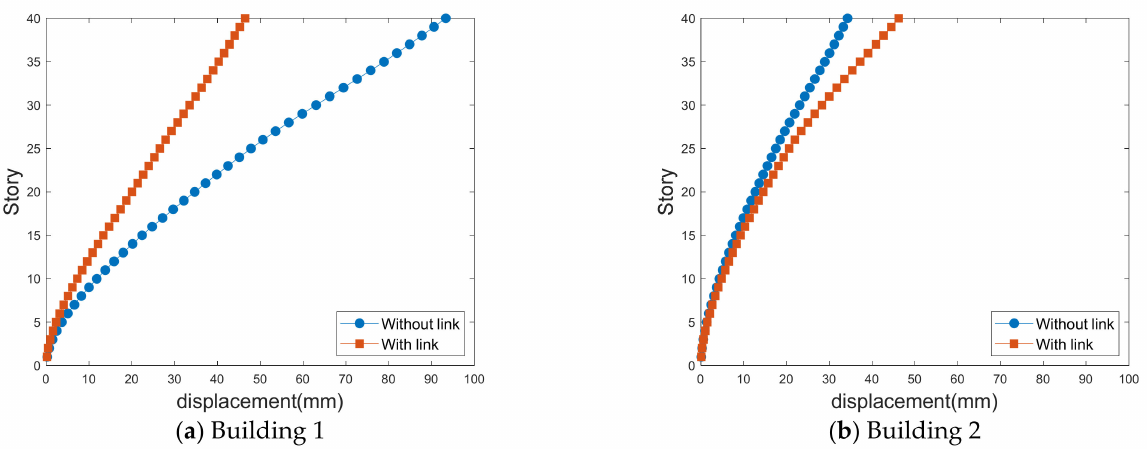
Figure 15. Crosswind-induced lateral displacement with a small gap